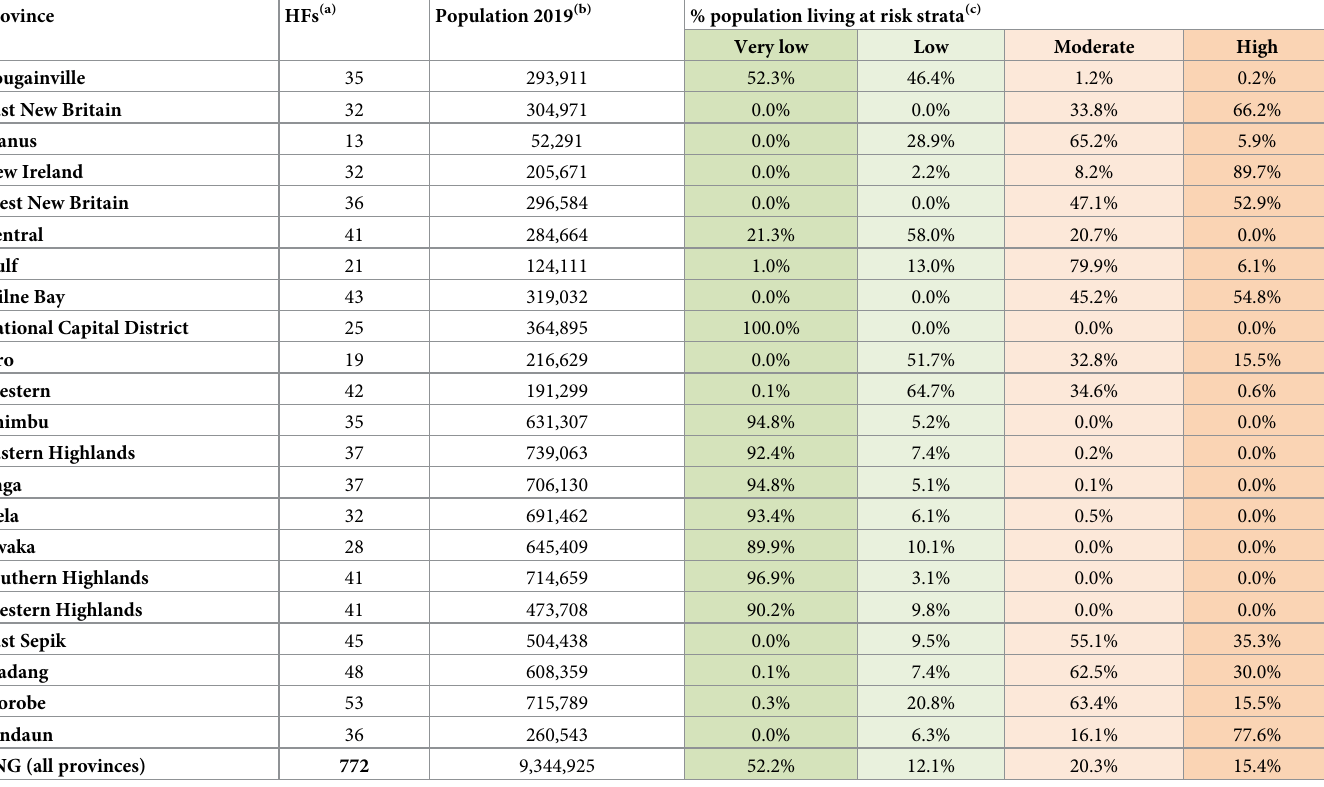
Table 4. Population distribution of PNG by province according to malaria incidence strata,